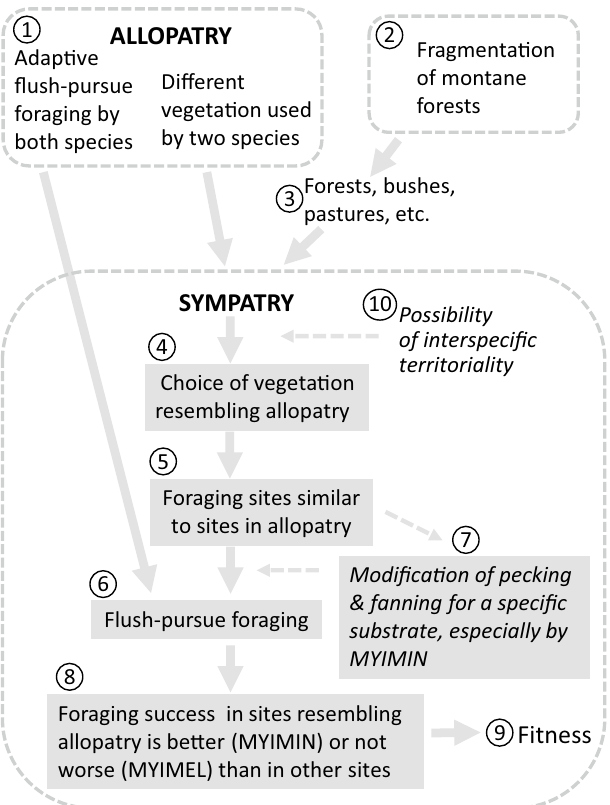
Figure 6. Hypothetical and documented phenomena covered by this research and by literature, and the connections between them to propose a hypothetical mechanism responsible for coexistence of high-elevation and low-elevation Myioborus species in the Andean zones of sympatry under anthropogenic changes of landscape. Shaded boxes indicate areas for which we have observational evidence. (1)—in allopatry the two species exhibit similar and likely deeply phylogenetically rooted flush-pursue foraging strategy and they use different species-specific habitats suggesting a possibility of divergent species-specific habitat preferences; (2)—human activities led to fragmentation of the montane forests; (3)—result of fragmentation is a landscape with a mosaic of primary and secondary forests mixed with shrubs and pastures, creating habitat patches resembling allopatric habitats of both species; (4)—species use habitat patches similar to their allopatric habitats and sympatry occurs, which may, hypothetically, be affected by interspecific territoriality (10) based on territorial responses to interspecific songs (observed but not reported here); (5)—each species chooses to forage on substrates and locations that are readily available in territory and following preferences developed during evolution in allopatry; (6)—both species forage in a similar manner, using flush-pursue strategy with small differences consistent with adaptations in allopatry; (7)—species exhibit behavioral plasticity and modify flush- pursue foraging according to foraging substrate (also documented in M. pictus 16 ); (8)—foraging success is a result of processes in nr 5, 6, 7 and abundance, distribution and profitability of available prey; (9)—the resulting foraging success may affect fitness, which may lead to new evolutionary processes in the anthropogenic zone of sympatry. Notice that this schematic is a hypothesis that should be tested in the future multiple studies at various locations in the Andes for several pairs of low-elevation and high-elevation species (some of which are presented in Fig. 1). See text in Discussion for more